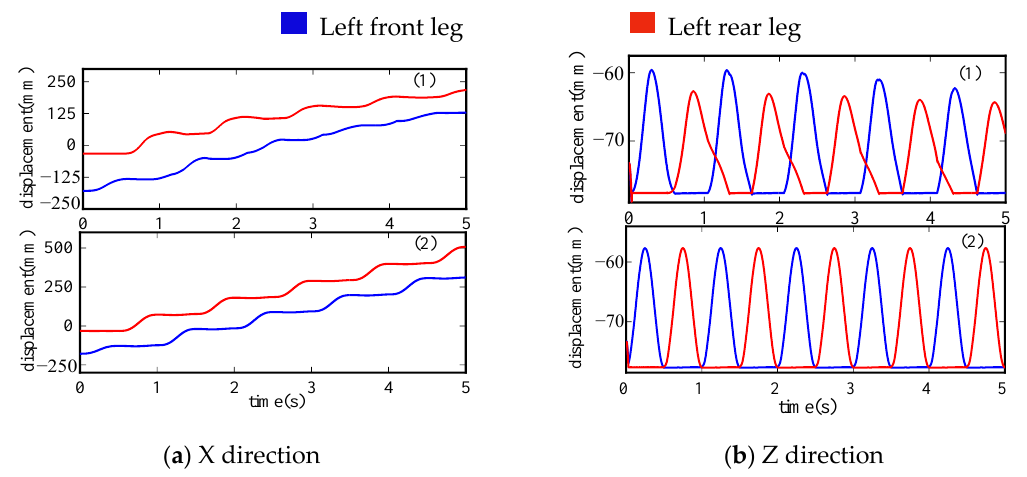
Figure 11. Comparison of foot displacement before and after optimization: ( a ) foot displacement curves in X direction cascade PID (1) and fuzzy adaptive PID (2); ( b ) foot displacement curves in X direction cascade PID (1) and fuzzy adaptive PID (2).